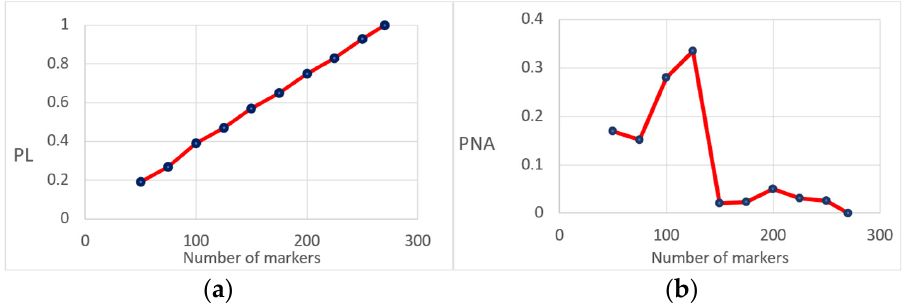
Figure 3. ( a ) Ratio of the average difference between the likelihood (PL) of the chosen parent and an unrelated individual for a different number of markers (expressed as a proportion when using all markers); ( b ) Proportion of non-assignment (PNA) given a different number of markers used for parentage testing.